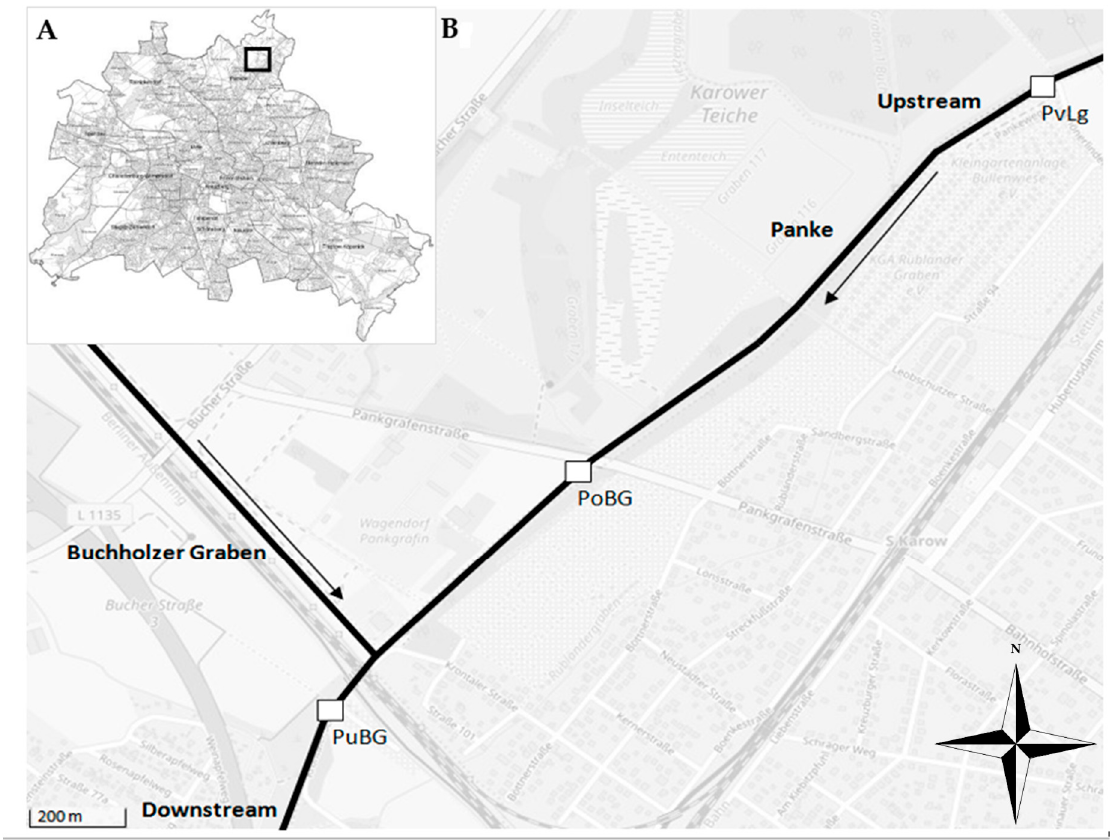
Figure 1. ( A ) The Berlin map shows the sampling area noted by a square. ( B ) Open squares highlight sampling sites. The clear water from the Schönerlinde WWTP enters in the Panke through the Buchholzer Graben. Map data copyrighted OpenStreetMap contributors (2018) and are available from http://www.openstreetmap.org.